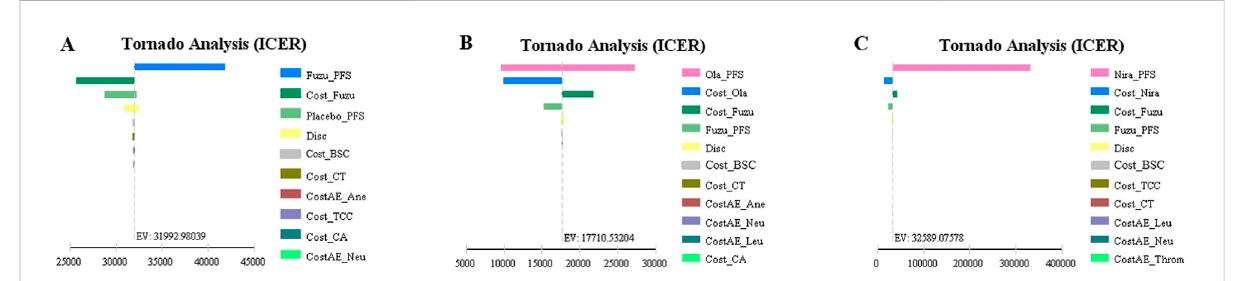
FIGURE 2 Tornado diagram of the one-way deterministic sensitivity analysis. (A) is the result of fuzuloparib maintenance therapy vs. RS, (B) is the result of fuzuloparib maintenance therapy vs. olaparib maintenance therapy, and (C) is the result of fuzuloparib maintenance therapy vs. niraparib maintenance therapy. PFS, progression-free survival; PD, progressed disease; AE, Adverse Event; CT, computed tomography; BSC, best supportive care; TCC, terminal care costs; RS, routine surveillance.